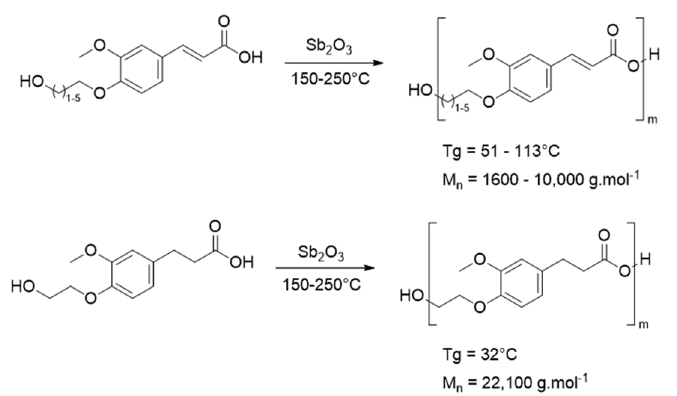
Scheme 1. Representation of the synthesis of polyesters from ferulic derivatives of different lengths as well as with and without hydrogenation. Adapted from [29].